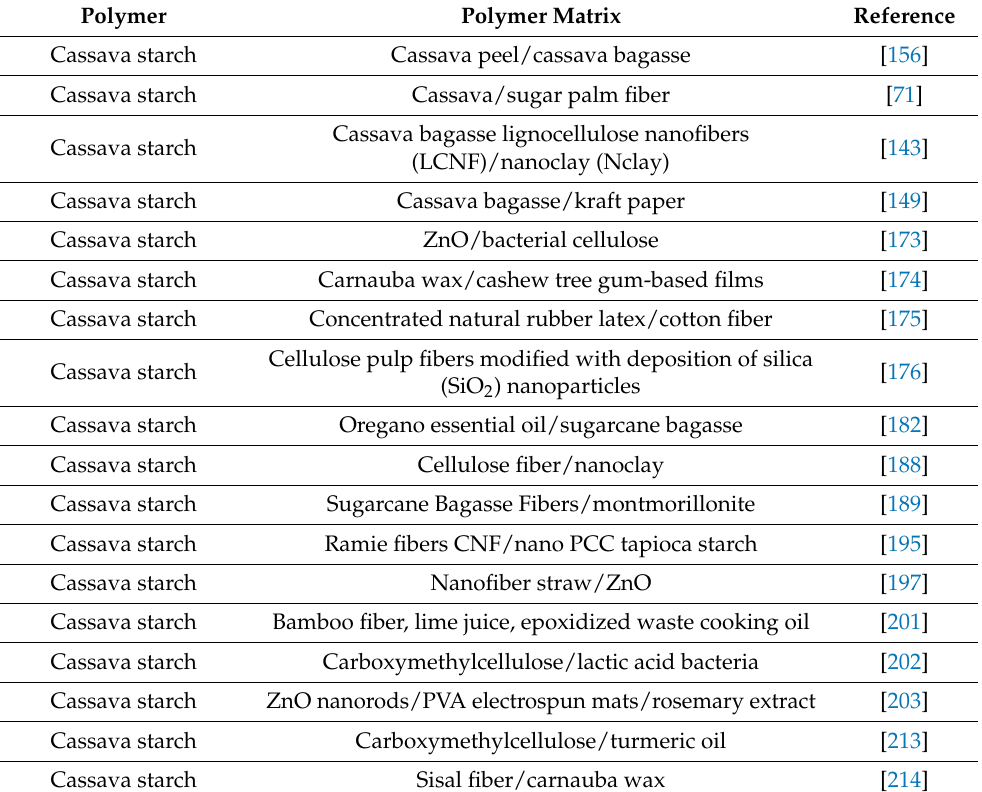
Table 8. For instance, Edhirej, Sapuan, Jawaid, and Zahari [71] worked on sugar palm fiber (SPF)-reinforced cassava starch/cassava bagasse. The biocomposite films were fabricated via casting method and plasticized with fructose. In their work, the amount of SPF loadings was varied by 2, 4, 6, and 8% w / w of dry starch, mixed with the CS/CB biocomposites. In addition, the authors claimed that the reinforcement of SPF had relatively enhanced the physical and mechanical properties, as well as reducing the water uptake, water content and water solubility, and the density of the composite films. According to SEM images, the filler was completely incorporated within the starch matrices. Hence, the film with higher SPF content, 8% w/w SPF/CS/CB, exhibited better heterogeneous film surface. Moreover, XRD analysis proved hybrid film modified with SPF had improved crystallinity up to 47% compared to 32% for the pristine starch film. Table 8. Reported work on cassava starch hybrid polymer